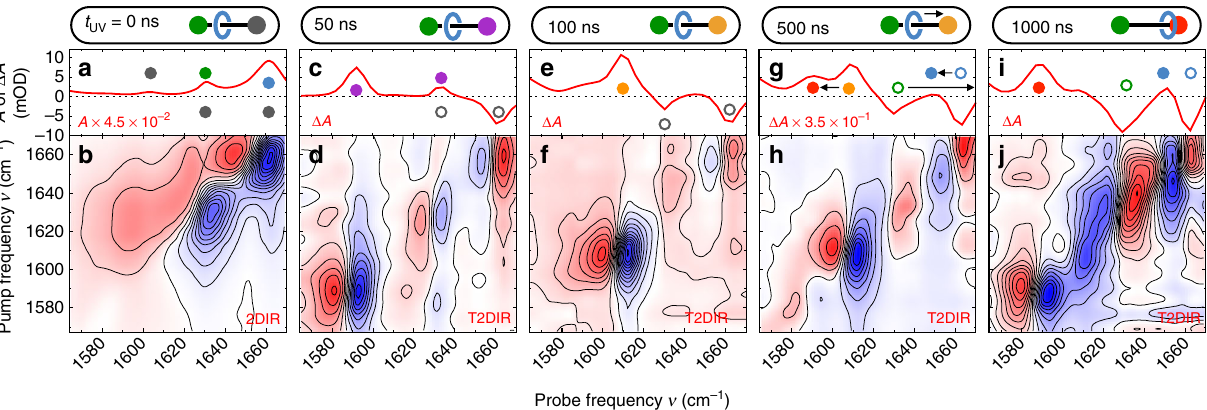
Fig. 2 Transient 2DIR spectra during the operation cycle of the molecular machine. a , c , e , g , i are the absorption ( A ) and change in absorption ( Δ A ) spectra; b , d , f , h , j are the corresponding 2DIR ( Δ A ) and T2DIR ( ΔΔ A ) spectra measured with parallel ( || ) polarisations of the IR-pump and IR-probe pulses. The coloured closed and open circles correspond to the labelled components of the molecular shuttle depicted schematically above the graphs. Arrows indicate spectral shifts caused by the shuttling of